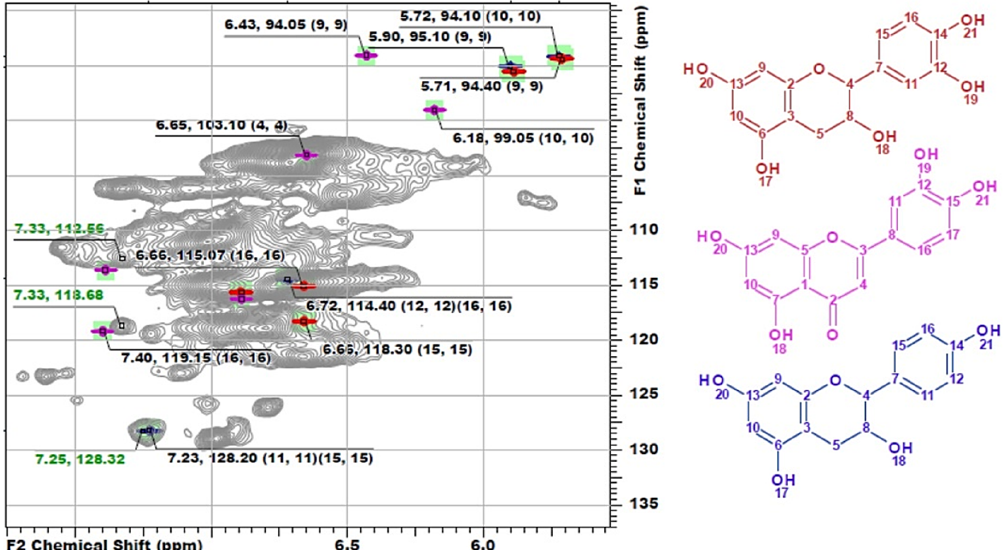
Figure 4. The comparison of model 1 H- 13 C HSQC spectra of catechin (red), luteolin (pink) and afzelechin (blue) with the obtained spectrum of DL-P preparation.